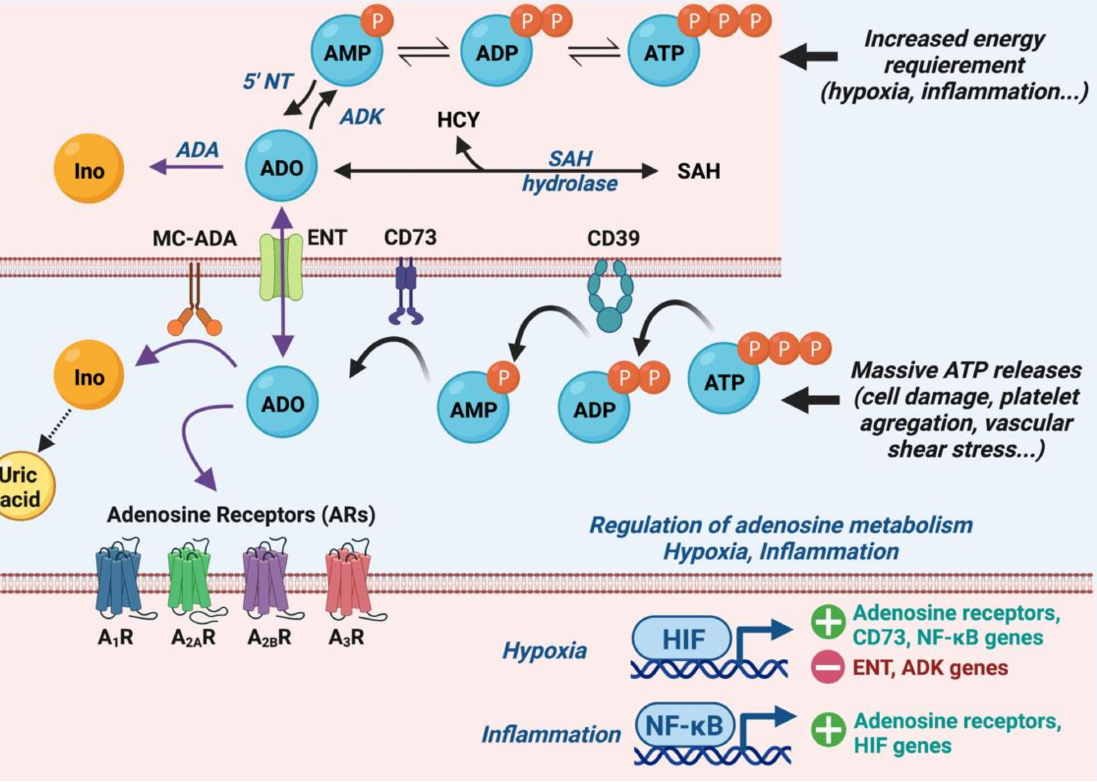
Figure 1. Adenosine metabolism. The sources of intracellular adenosine (ADO) come partly from the methionine cycle by the hydrolysis of S-adenosylhomocysteine (SAH) and mainly from the ATP dephosphorylation cascade when cellular energy requirement increases. Massive extracellu- lar release of ATP produces adenosine by the consecutive actions of ectonucleoside triphosphate diphosphohydrolase-1 (CD39) and ecto-5’-nucleotidase (CD73). Adenosine can bind to adenosine receptors (ARs), but it is also reuptake by equilibrative nucleoside transporters (ENT 1–2 ) and rephos- phorylated by adenosine kinase (ADK). Adenosine is catabolized by adenosine deaminase (ADA) into inosine (Ino) and, finally, joins uric acid metabolism. Hypoxia and inflammation increase the expression of adenosine receptors and the production of extracellular adenosine: HIF promotes the transcription of adenosine receptors and CD73 and NF-kB genes and represses ENT and ADK genes; NF- κ B promotes the transcription of adenosine receptors and HIF genes. ATP: adenosine triphosphate; ADP: adenosine diphosphate; AMP: adenosine monophosphate; HCY: homocysteine; HIFs: hypoxia-inducible transcription factors; MC-ADA: mononuclear cell ADA; NF-kB: nuclear factor-kappa